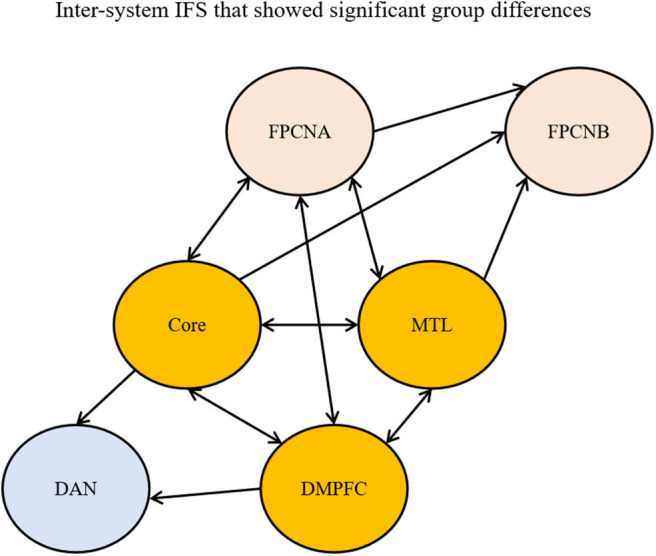
Inter-subsystem IFS showing significant group differences (p < 0.01). A single arrow indicates that the unidirectional connection between networks was decreased in AD. Double arrows indicate that the reciprocal connections between networks were decreased in AD. FPCNA, frontoparietal control network A; FPCNB, frontoparietal control network B; DM, dorsomedial prefrontal cortex; MTL, medial temporal lobe subsystem; DAN, dorsal attention network.